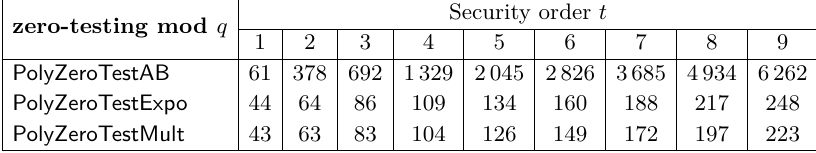
Table 4: Operation count for polynomial zero testing with arithmetic masking modulo q , with n = t + 1 shares, ℓ = 768 coefficients, in thousands of operation, with q = 2 13 for PolyZeroTestAB and q = 3329 for PolyZeroTestExpo and PolyZeroTestMult . We use κ = 11, in order to reach 128 bits of security.